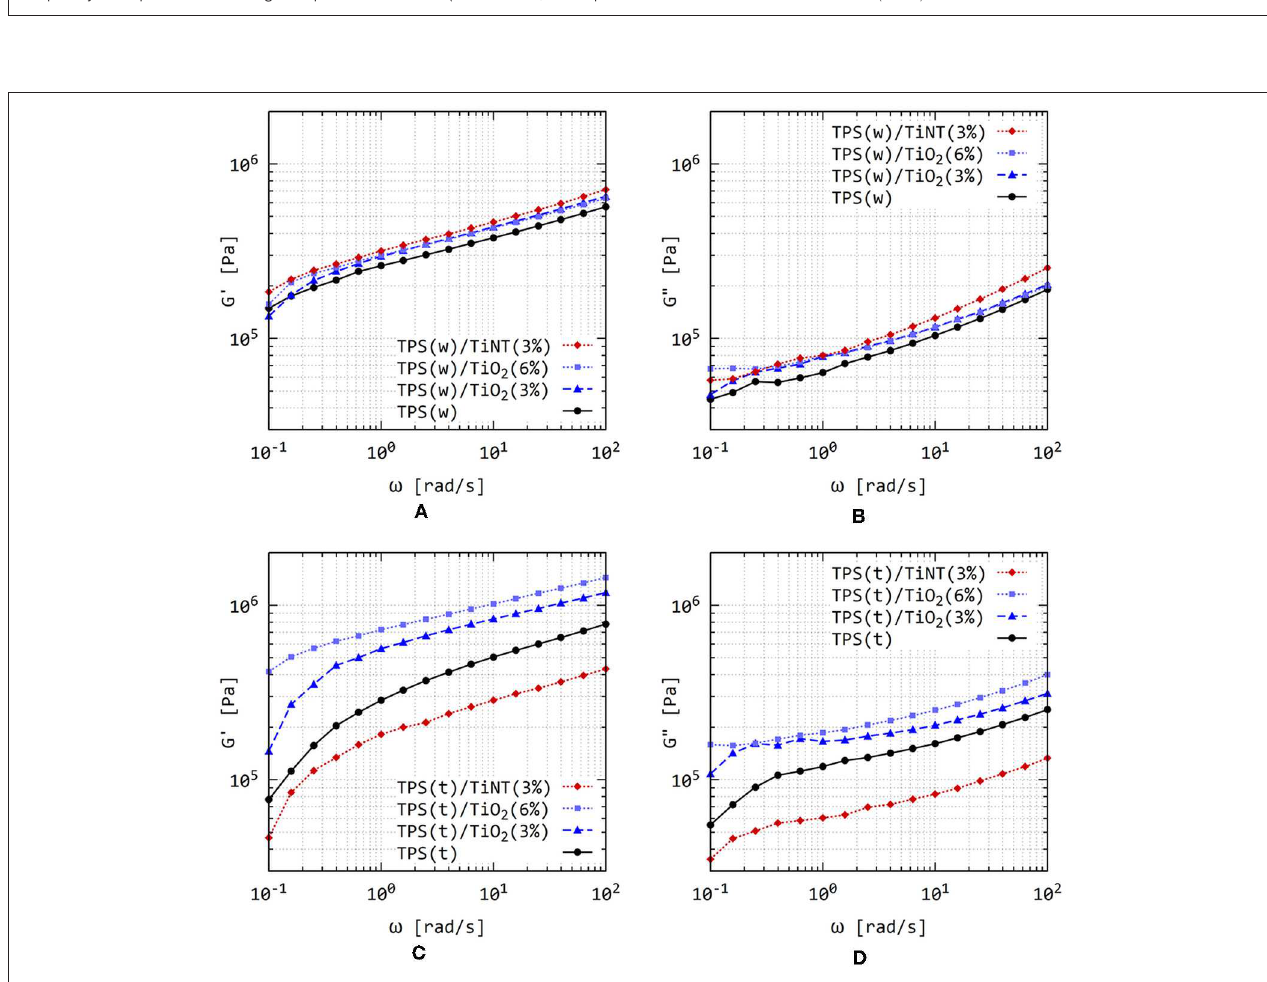
FIGURE 7 | The values of storage modulus ( G ′ ) (A,C) and loss modulus ( G ′′ ) (B,D) of wheat (A,B) and tapioca (C,D) TPS/TiX composites at 120 ◦ C and strain 0.02%.